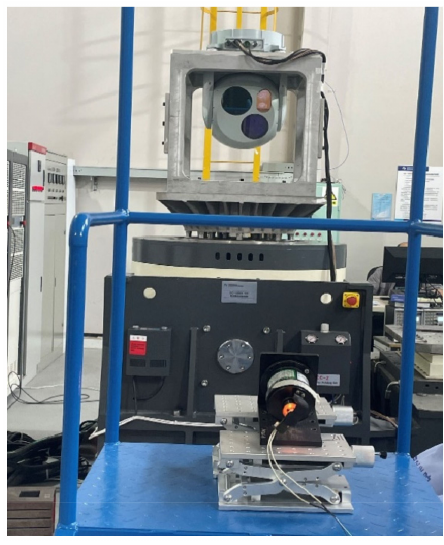
Figure 19. Vibration test device.